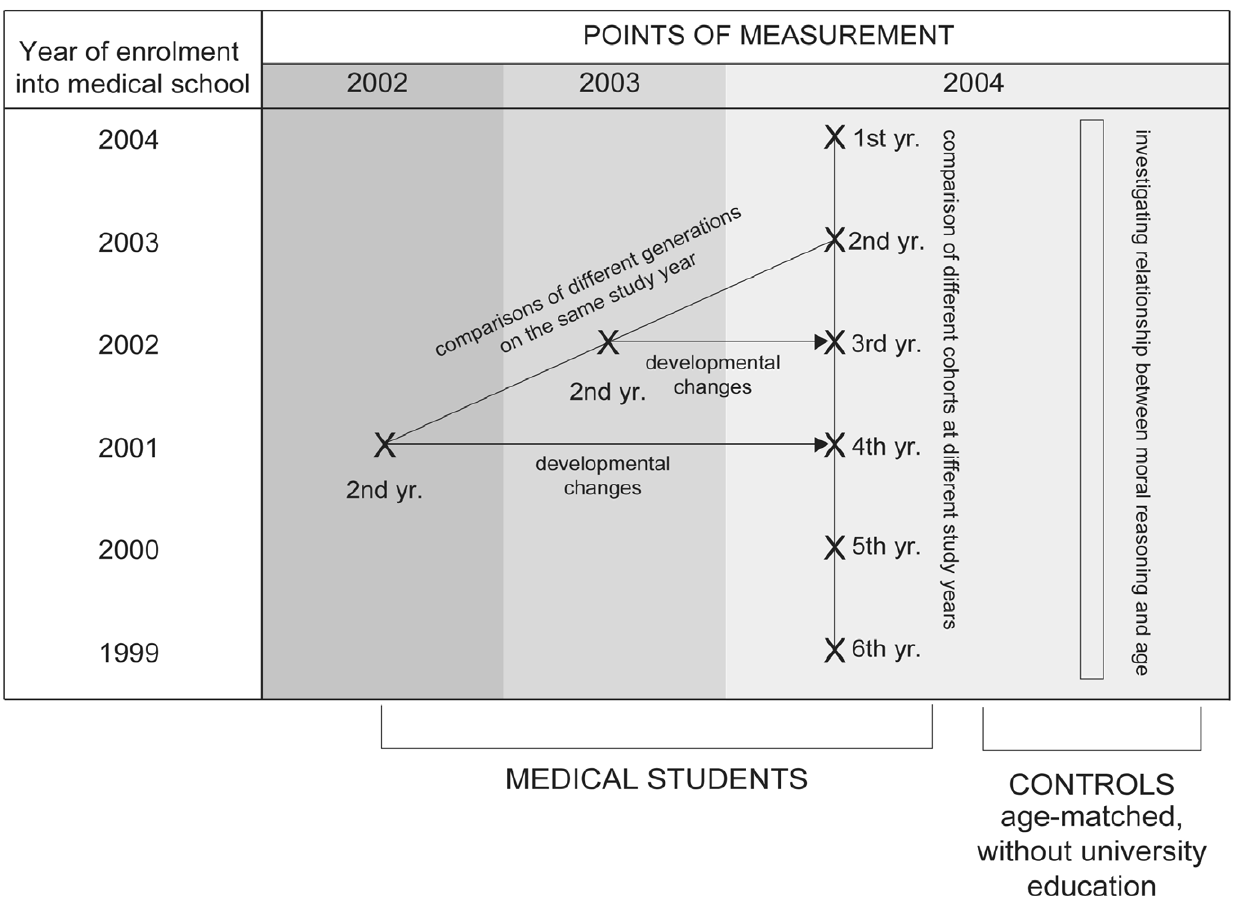
Figure 1. Study design.